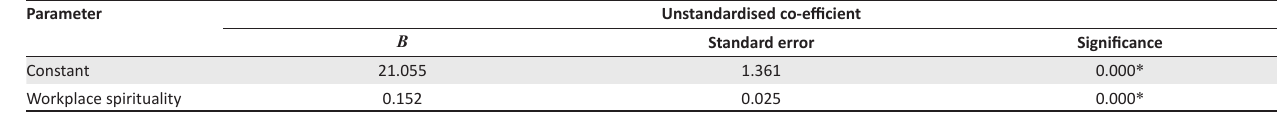
TABLE 4: Parameter estimates for workplace spirituality on employee physical health. Parameter